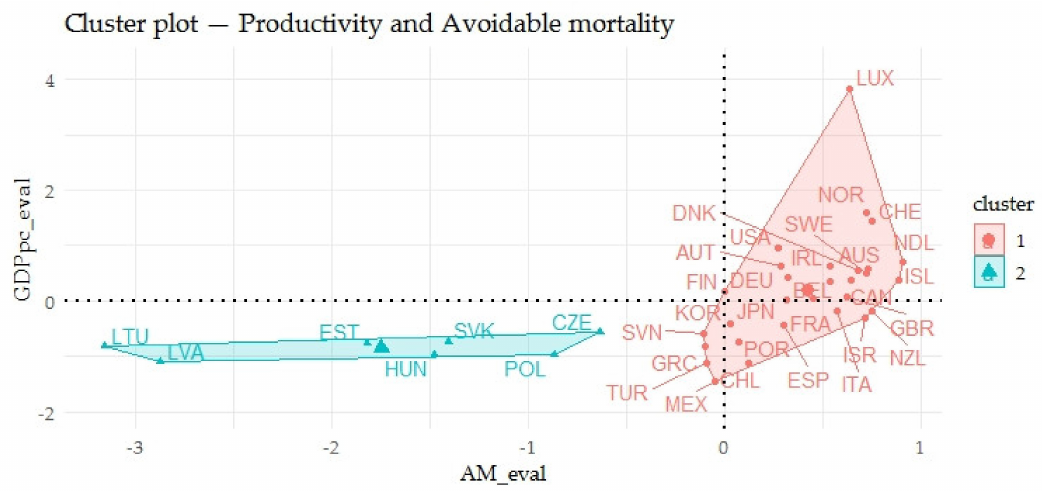
Figure 6. Clusters of OECD—the relations of economic prosperity and gender inequalities in avoidable